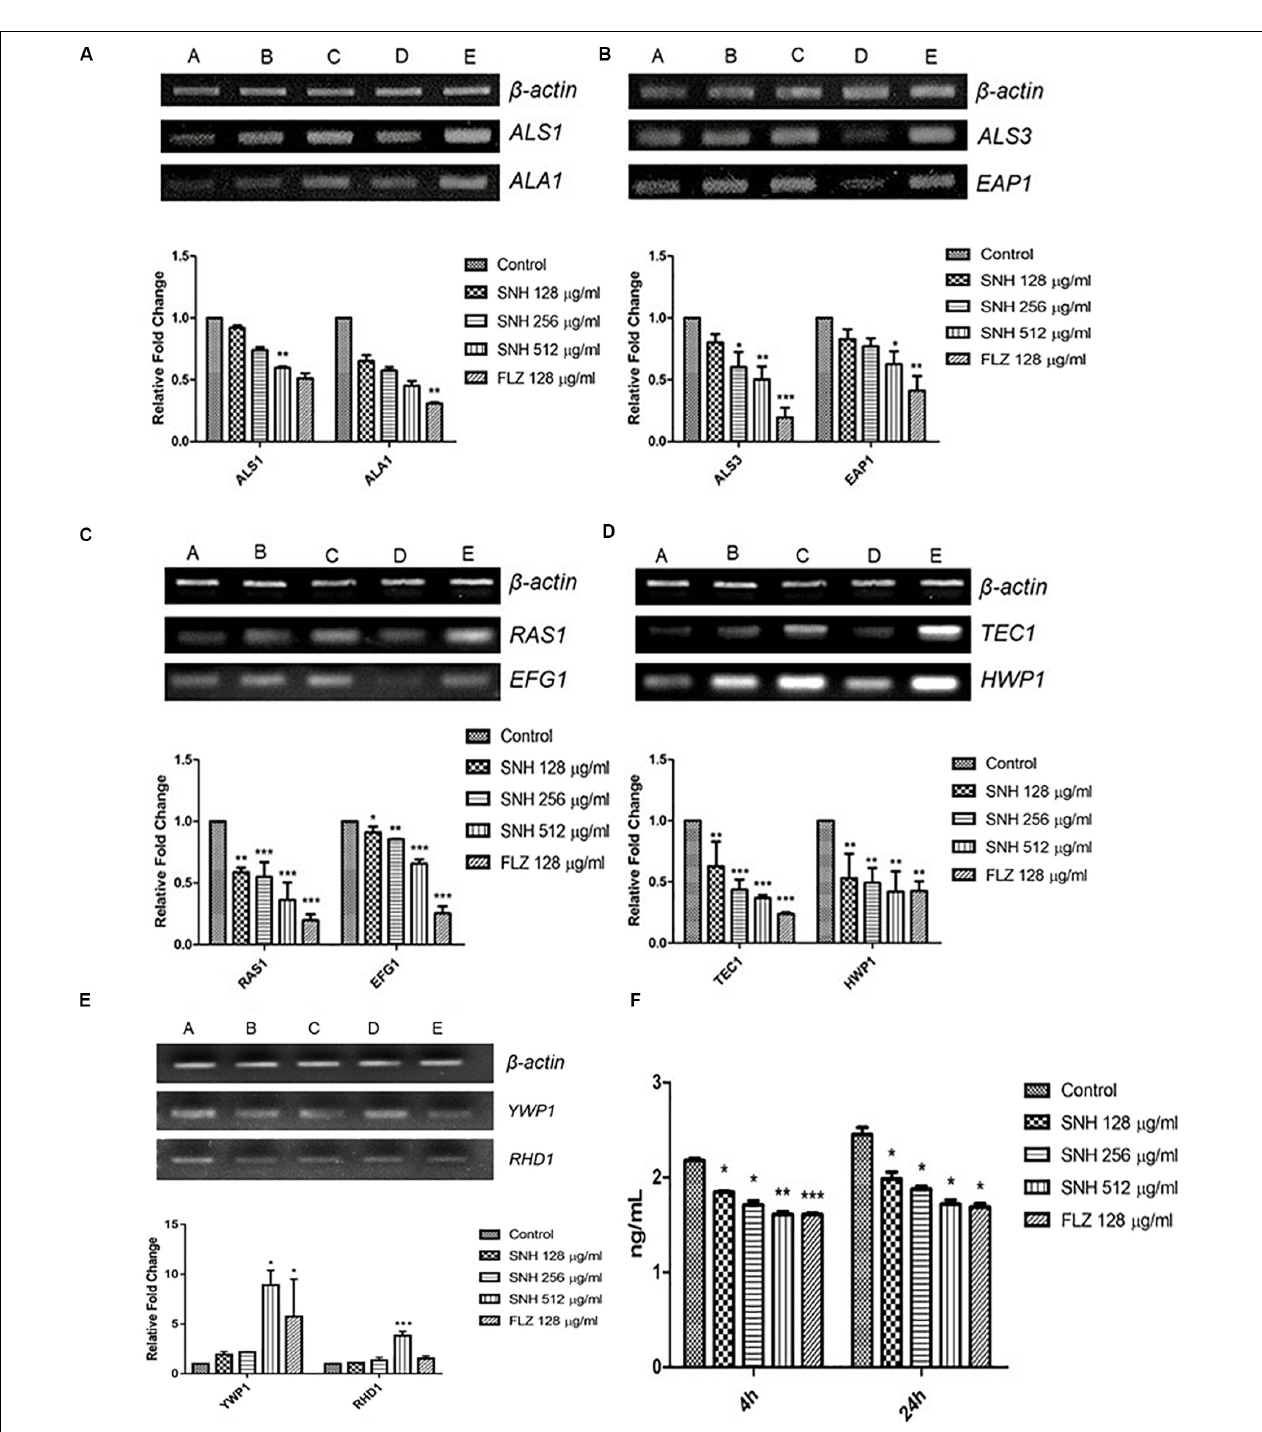
FIGURE 6 | Expression changes of biofilm related genes and protein of Ras1-cAMP-Efg1 pathway by SNH treatment in C. albicans SC5314. (A) The expression levels of adhesion-related genes ALA1 and ALS1 . (B) The expression levels of biofilm-related genes ALS3 and EAP1 . (C − D) The expression levels of Ras1-cAMP-Efg1 pathway-related genes RAS1, EFG1, TEC1, and HWP1. (E) The expression of yeasts-related genes YWP1 and RHD1 . Gene expression results were detected by RT-PCR nucleic acid electrophoresis bands and qRT-PCR quantitative analysis. The drug-free strain-containing medium was set as the control. Data are shown as mean ± SD. ( A,B,C,D,E ) were respectively expressed as SNH 512 µ g/mL group, SNH 256 µ g/mL group, SNH 128 µ g/mL group, and FLZ 128 µ g/mL group, Control group. * p < 0.05, ** p < 0.01, and *** p < 0.001 are calculated by comparing with the control group. (F) Effects of SNH on the production of cAMP protein of C. albicans SC5314. The drug-free strain-containing medium was set as the control. Data are shown as mean ± SD. * p < 0.05, ** p < 0.01, and *** p < 0.001 are calculated by comparing with the control group.